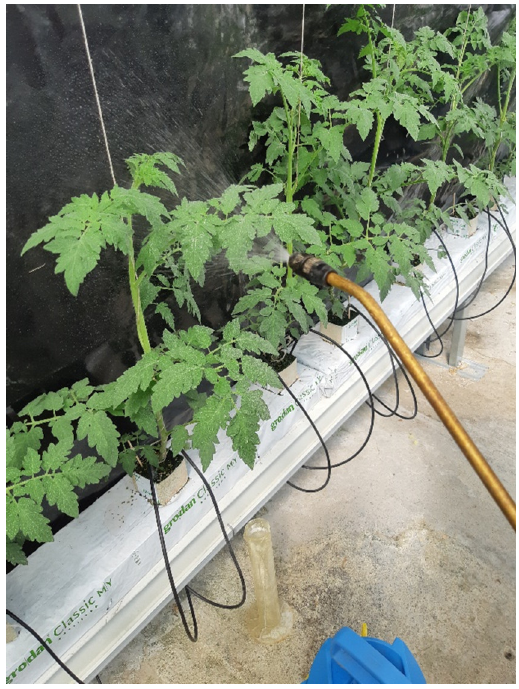
Figure 2. Application of strigolactone-based biostimulant by spraying the leaves 15 DAT. Maxicrop contains mainly seaweed extracts from Ascophyllum nodosum and can be